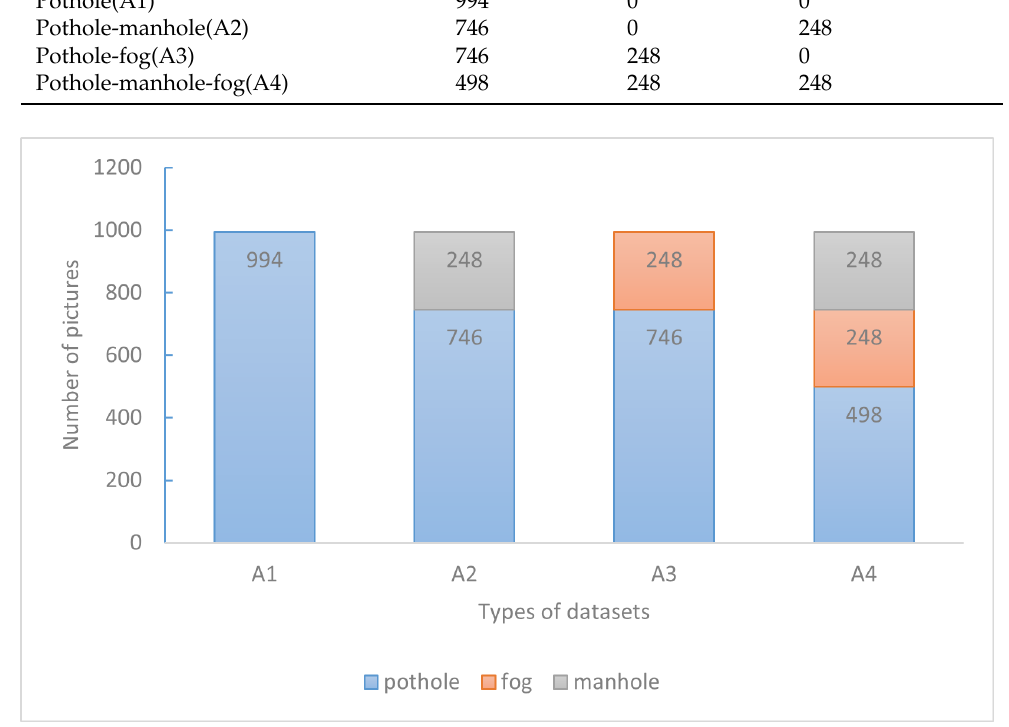
Figure 8. Self-made datasets and augmented number of pictures in the